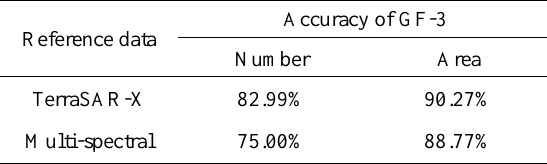
Table 12. Change detection accuracy of GF-3